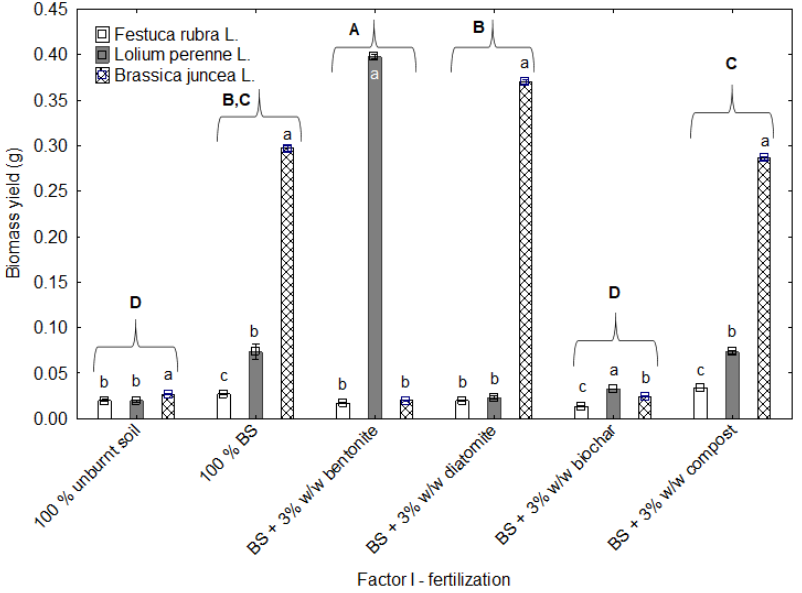
Figure 11. Aboveground biomass yield of Festuca rubra L., Lolium perenne L. and Brassica juncea L. from a pot experiment carried out for unburnt soil, burnt soil, and burnt soil supplemented with different amendments. Average values of plant biomass (n = 3) ± SE are presented; different small letters indicate significant differences between individual plants within one variant. Different uppercase letters in bold indicate significant differences in average (n = 9) plant biomass yield between individual variants.